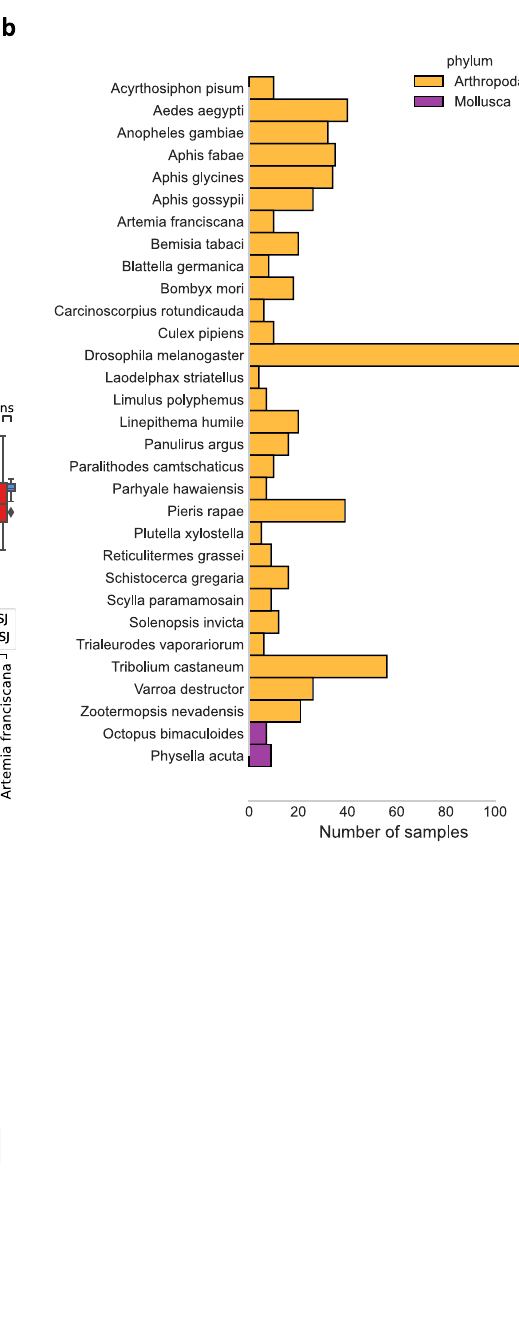
COMMUNICATIONS BIOLOGY| (2023) 6:93 |https://doi.org/10.1038/s42003-023-04471-4|www.nature.com/commsbio